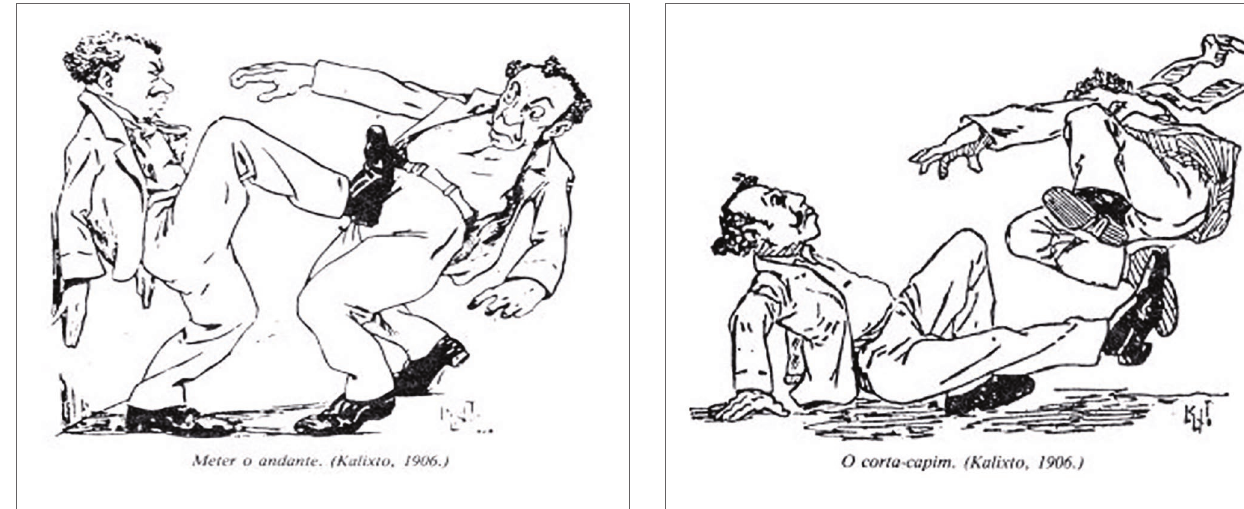
FIGURE 6 | Tuck the move. FIGURE 5 | The